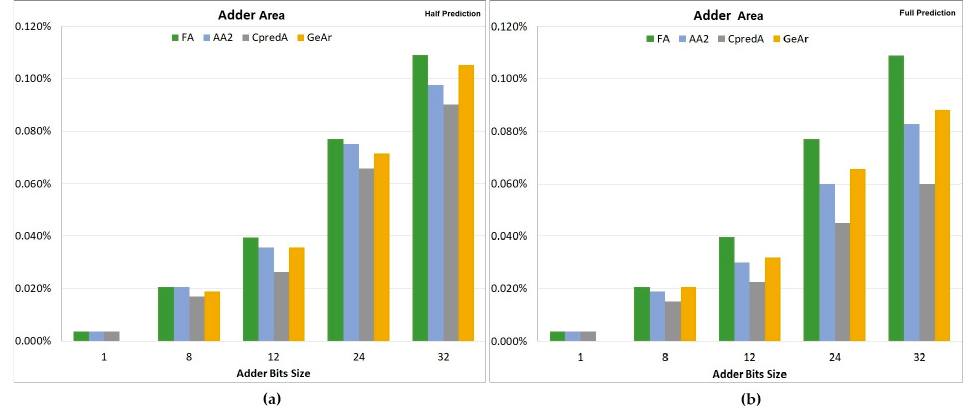
Figure 10. Adders area in ( a ) half prediction, ( b ) full prediction configurations.